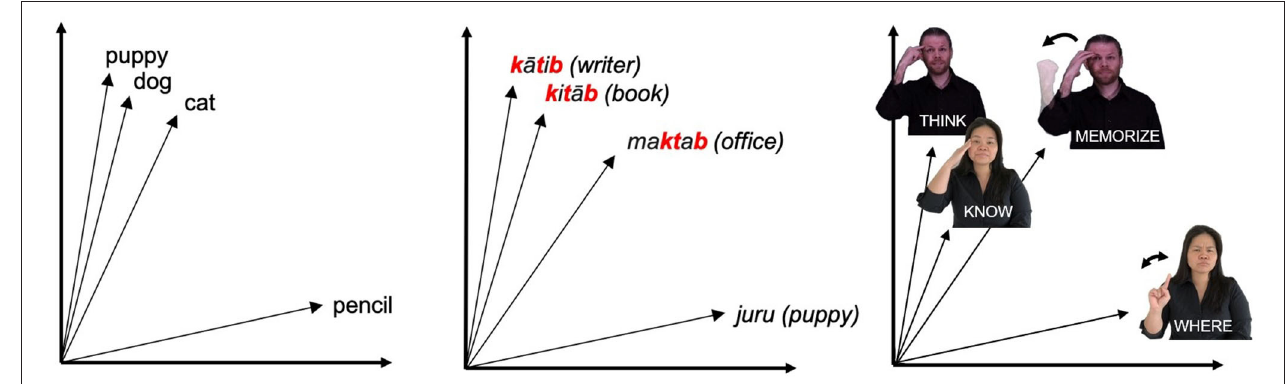
FIGURE 3 | Example English and Arabic words and ASL signs represented in vector